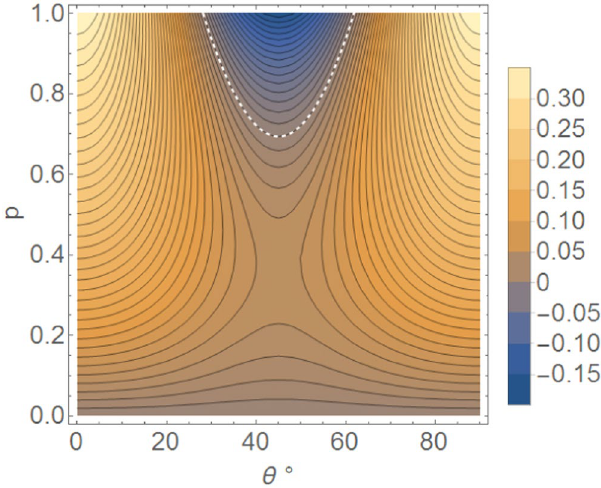
Figure 4. Success probability enhancement (difference) of our protocol in sending a qubit | ψ A 〉 = e i φ cos θ |H 〉 + sin θ |V 〉 through a depolarization channel, with respect to distilled quantum teleportation protocol 12 . The region above the dashed line is the only region where the latter has higher success probability. The degree of depolarization is parametrized by p , and θ is plotted between 0° and 90°. The plot is symmetric respect to θ =